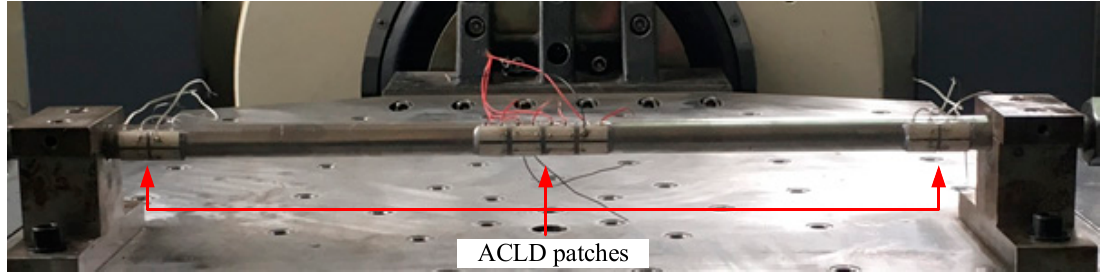
Figure 11. Layout of ACLD patches.